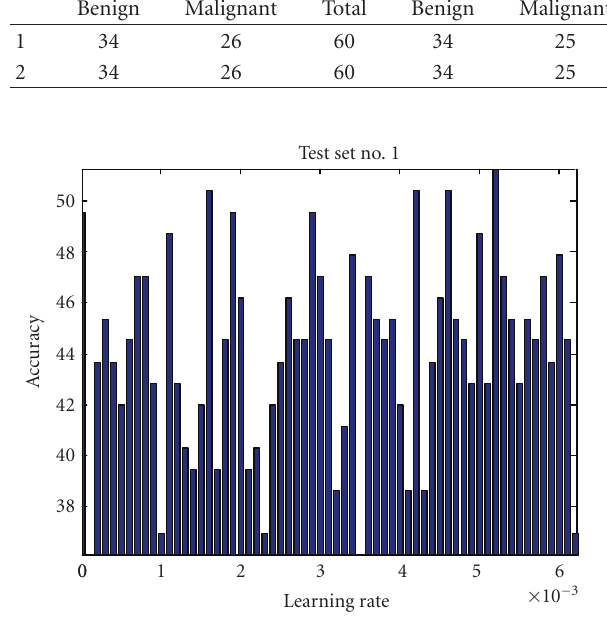
Figure 4: Learning rate impact on algorithm accuracy for test set no. 1 where other parameters are kept constant.